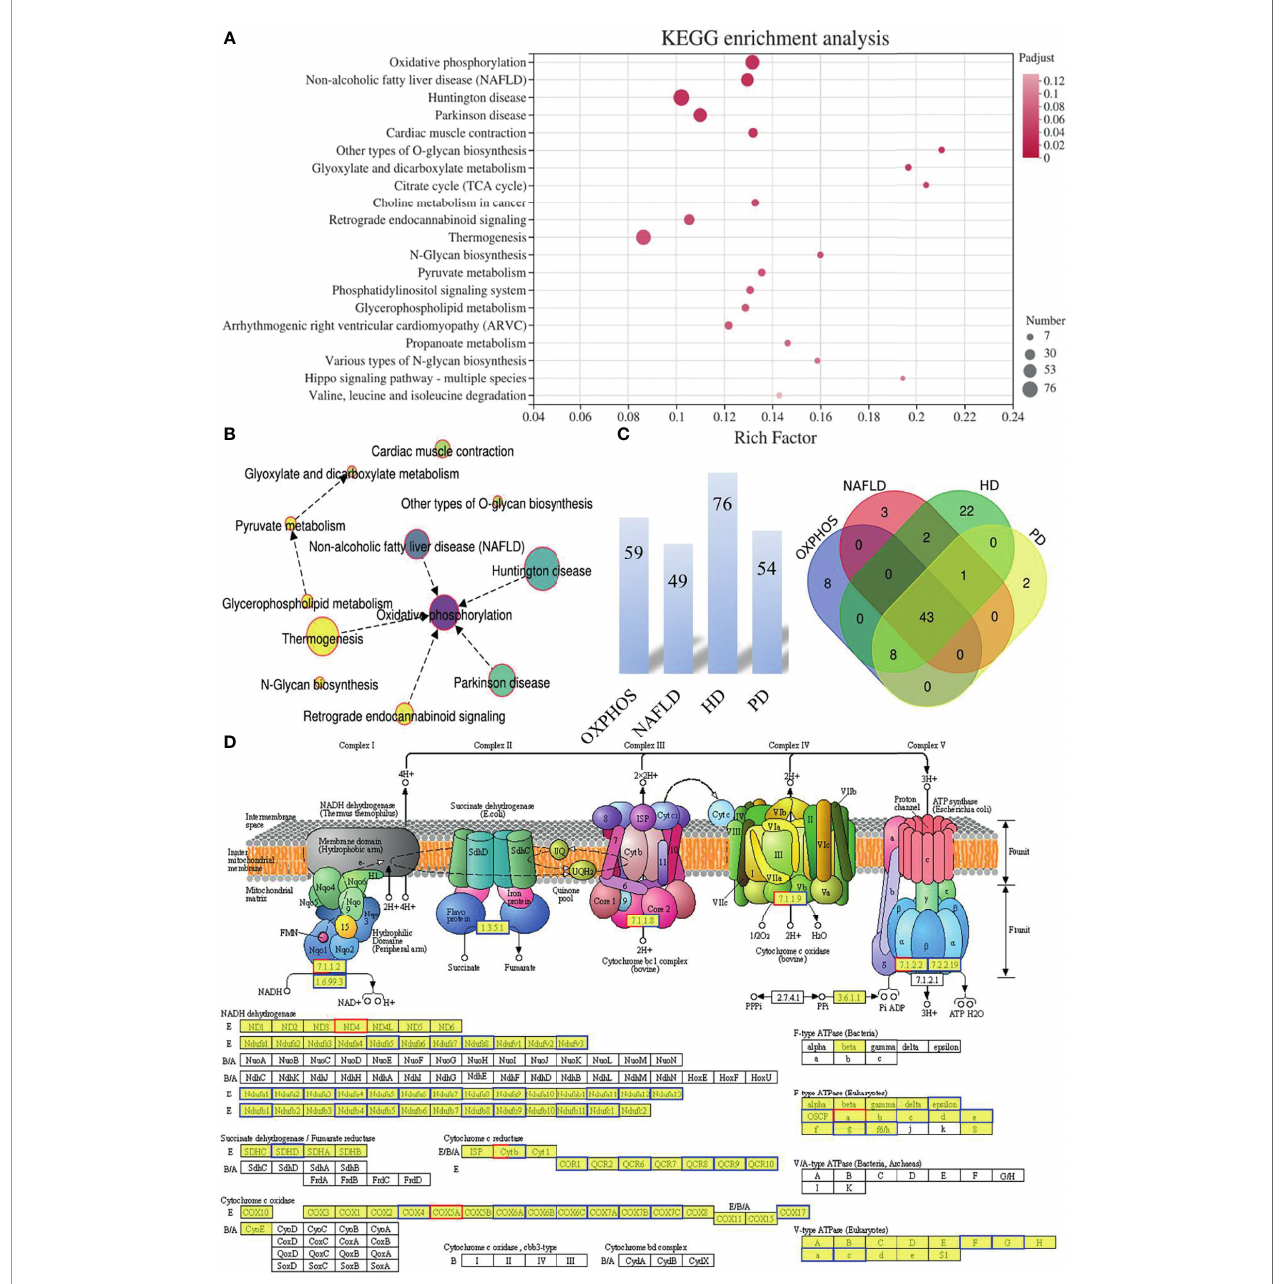
FIGURE 2 | The functional pattern of gene expression between IVO and IVM groups. (A) The top 20 enriched KEGG pathways for the DEGs identi fi ed between the IVO and IVM groups. The X-axis represents the Rich Factor while the Y-axis represents the names of the pathways. The higher the Rich factor, the higher the degree of enrichment. (B) Network chart showing the signi fi cantly enriched KEGG pathways. (C) The number above each bar indicates the enriched DEGs of the top four terms (the OXPHOS, NAFLD, HD, and PD pathways) and the Venn diagram shows the overlapping DEGs between the top four enriched KEGG pathways. (D) KEGG pathway diagram for oxidative phosphorylation. Boxes with red borders represent up-regulated genes while boxes with blue borders represent down-regulated genes when the IVO group was compared with the IVM